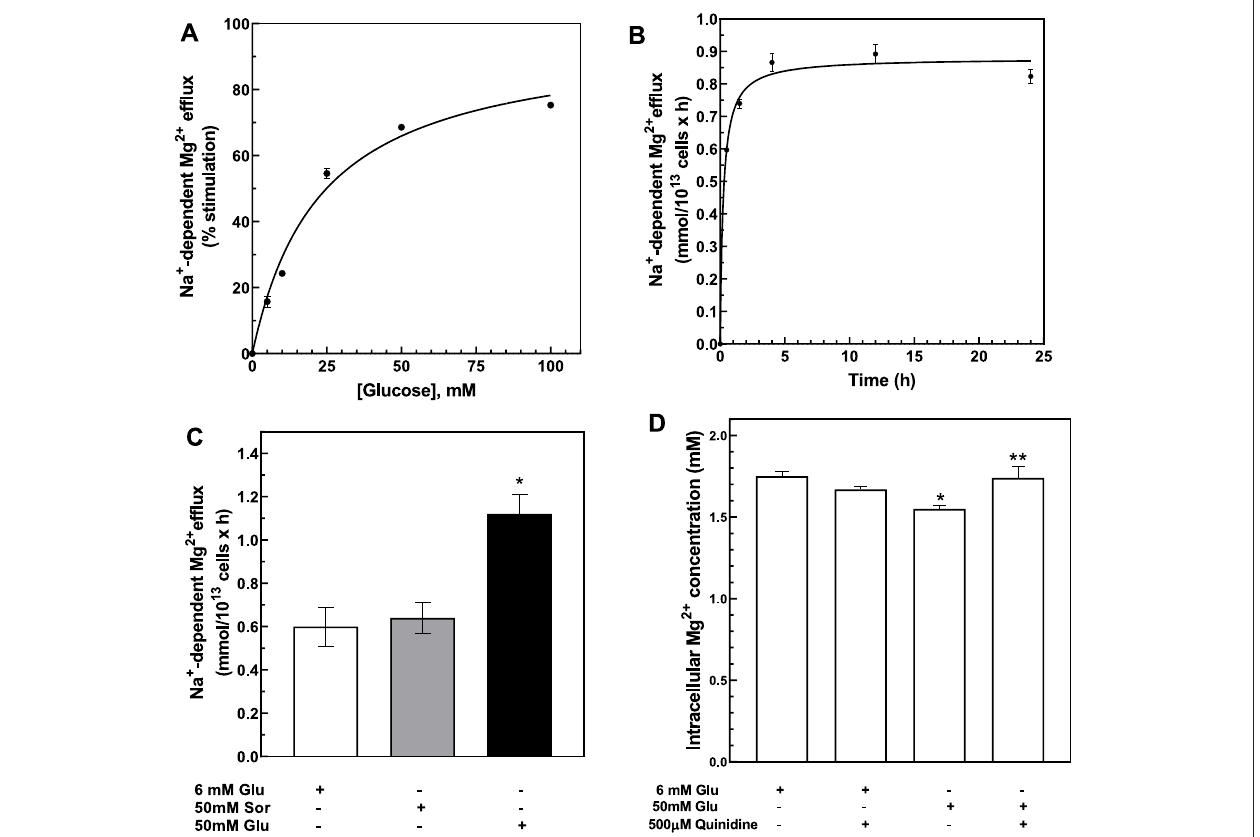
FIGURE2| ActivationofNa + -dependentMg 2+ ef fl uxbyglucose. (A) Glucosedose-dependentactivationofNa + -dependentMg 2+ ef fl ux.Cellsfromnormalsubjects were incubated with 0 – 100 mM D-glucose for 24 h and assayed for Na + -dependent Mg 2+ ef fl ux or Na + /Mg 2+ exchanger activity. Hyperbolic pattern curve best fi t was used to derive V max = 0.978 ± 0.01 FU, K m = 3.2 ± 0.5 mM. Plot shows % of stimulation over 0 glucose present. Values are expressed as means ± SE of three experiments in triplicate determinations (r = 0.998). Plot shows % of stimulation over 0 glucose present. (B) Time course of glucose-dependent activation of the Na + /Mg 2+ exchanger. Cells from normal subjects were incubated with 50 mM D-glucose for 0 – 24 h and assayed for Na + /Mg 2+ exchanger activity as described in Methods.Hyperbolicpatterncurvebest fi twasusedtoderiveV max =0.98±0.01FU,reachinghalf-activityin1.6±0.0 h(r=0.90).Valuesareexpressedasmeans±SEM of three experiments in triplicate determinations. (C) Activation of Na + /Mg 2+ exchanger by glucose but not sorbitol. Cells from normal subjects were incubated with 6 or 50 mM D-glucose or 50 mM sorbitol solutions for 24 h and assayed for Na + /Mg 2+ exchanger activity as described in Methods. Values represent the activity of the exchanger and are expressed as means ± SEM. (* paired non-parametric t test, p < 0.005, n = 3). (D) Effect of quinidine on glucose-induced cellular Mg 2+ levels. Cells from normal subjectswere incubated with 6or 50 mM glucoseand in the presence or absenceof500 μ M quinidine for 1.5 hand assayed for total cellular Mg 2+ content as described in Methods. Results are expressed as means ± SEM of four experiment in triplicates. (* unpaired non-parametric t test 6 vs. 50 mM glucose p < 0.05; ** paired non-parametric t test 50 mM glucose vs. 50 mM glucose plus 500 μ M quinidine p < 0.04).